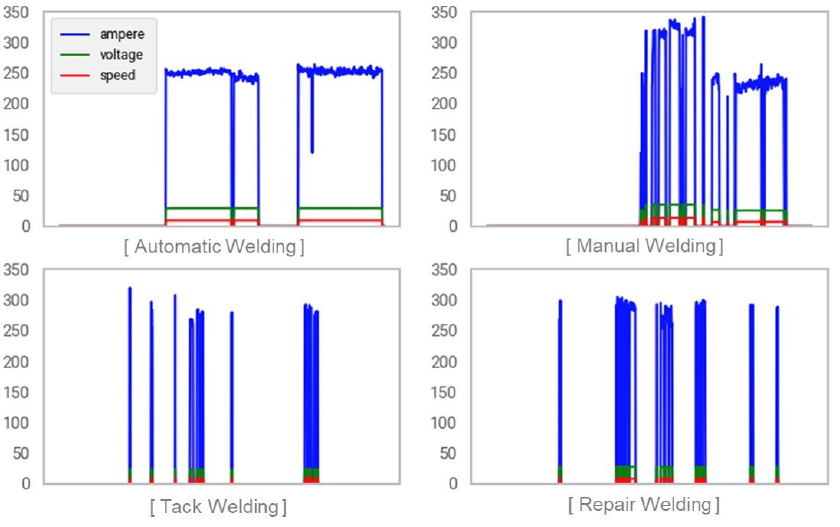
Figure 13. Time series graph by welding